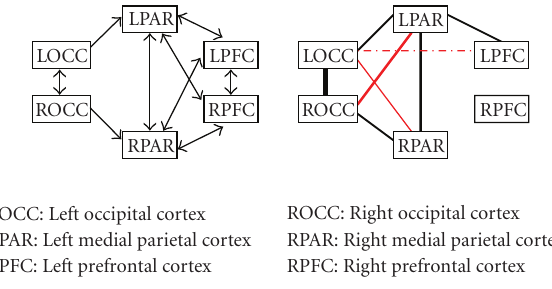
Figure 2: The network and results for Fletcher et al.